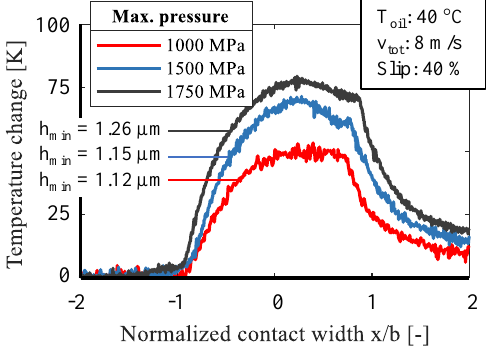
Figure 6. Influence of pressure at fluid friction on temperature change.